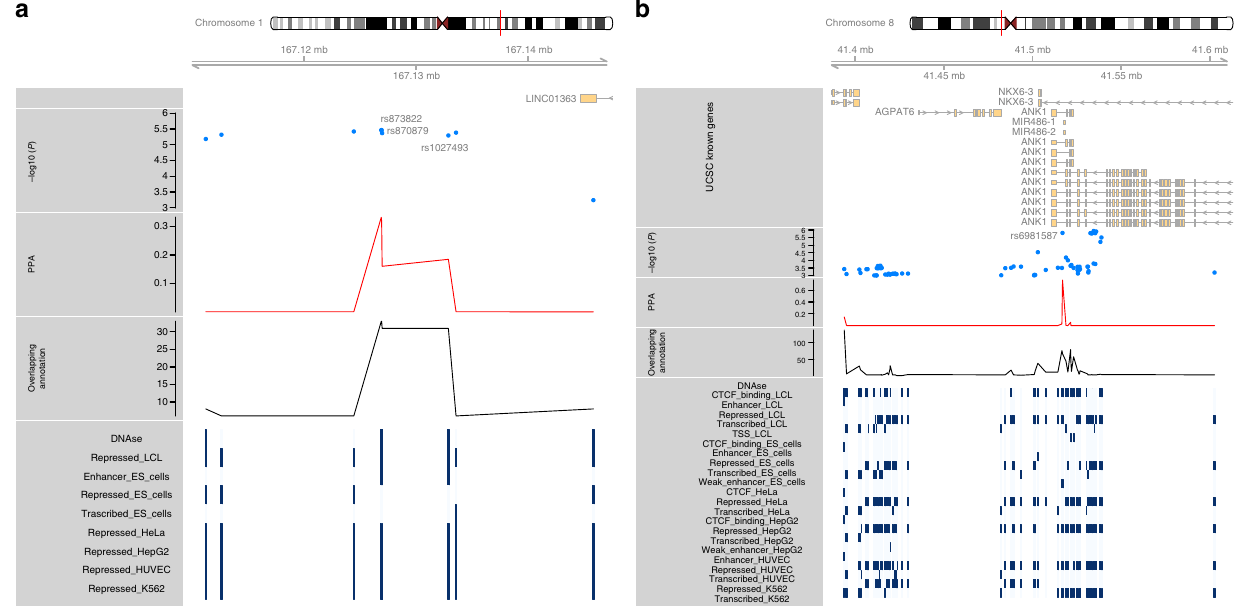
Fig. 3 Bayesian risk variant inference for SNPs within the RBSG4 and the MIR486 / NKX6.3 loci . Panel ( a ) corresponds to RBSG4 (LINC01363) and panel ( b ) to MIR486/NKX6.3. Tracks from top to bottom display: (1) gene track, (2) − log10 association p -values from the meta-analysis, (3) posterior probability of disease association (PPA), (4) the number of overlapping epigenomic annotation at a given marker, (5) the detail of the epigenomic marks that overlap a given variant. The risk inference analyses are limited to variants with p-values smaller than 10 − 3 ; all other variants are not displayed. Due to a large number of DNase annotation tracks (>100 for speci fi c variants), these tracks have been reduced to a single one (referred as “ DNase ” ). Source data are provided